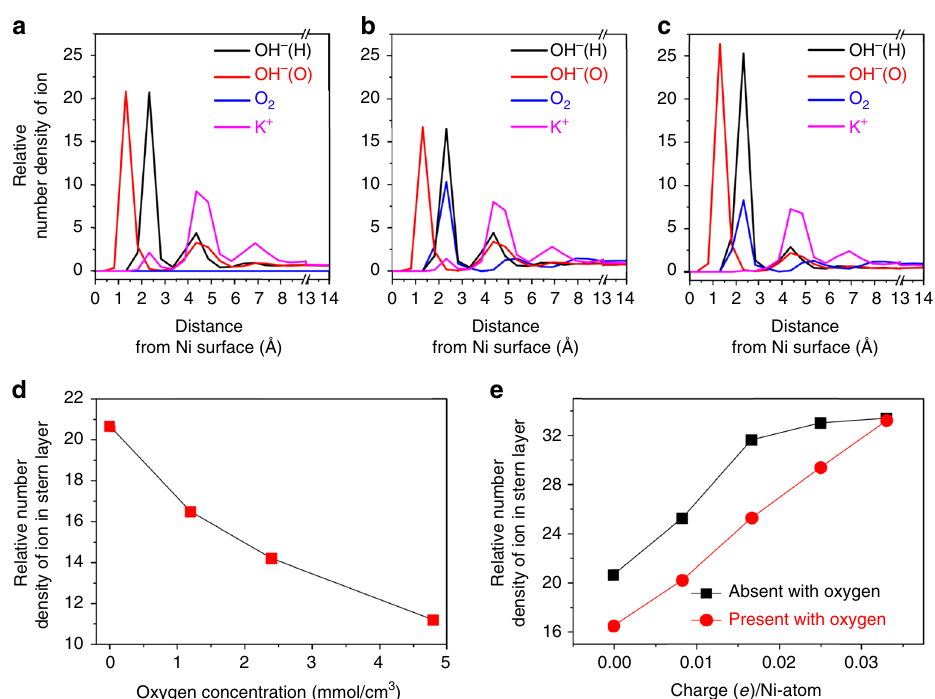
Fig. 4 MD simulation results. a Relative number density ρ of different electrolyte ions as a function of distance from the Ni cathode surface with oxygen concentration of 0. b Relative number density ρ of different electrolyte ions as a function of distance from the Ni cathode surface with oxygen concentration of 0.12 mmol/cm 3 . c Relative number density ρ of different electrolyte ions as a function of distance from the Ni cathode surface with oxygen concentration of 0.12 mmol/cm 3 and with a charge of +0.0083 e /Ni-atom. d The relative number density ρ of OH − ions as a function of the concentration of oxygen in the electrolyte. e The relative density of OH − ions in the stern layer as a function of the charge number for per Ni